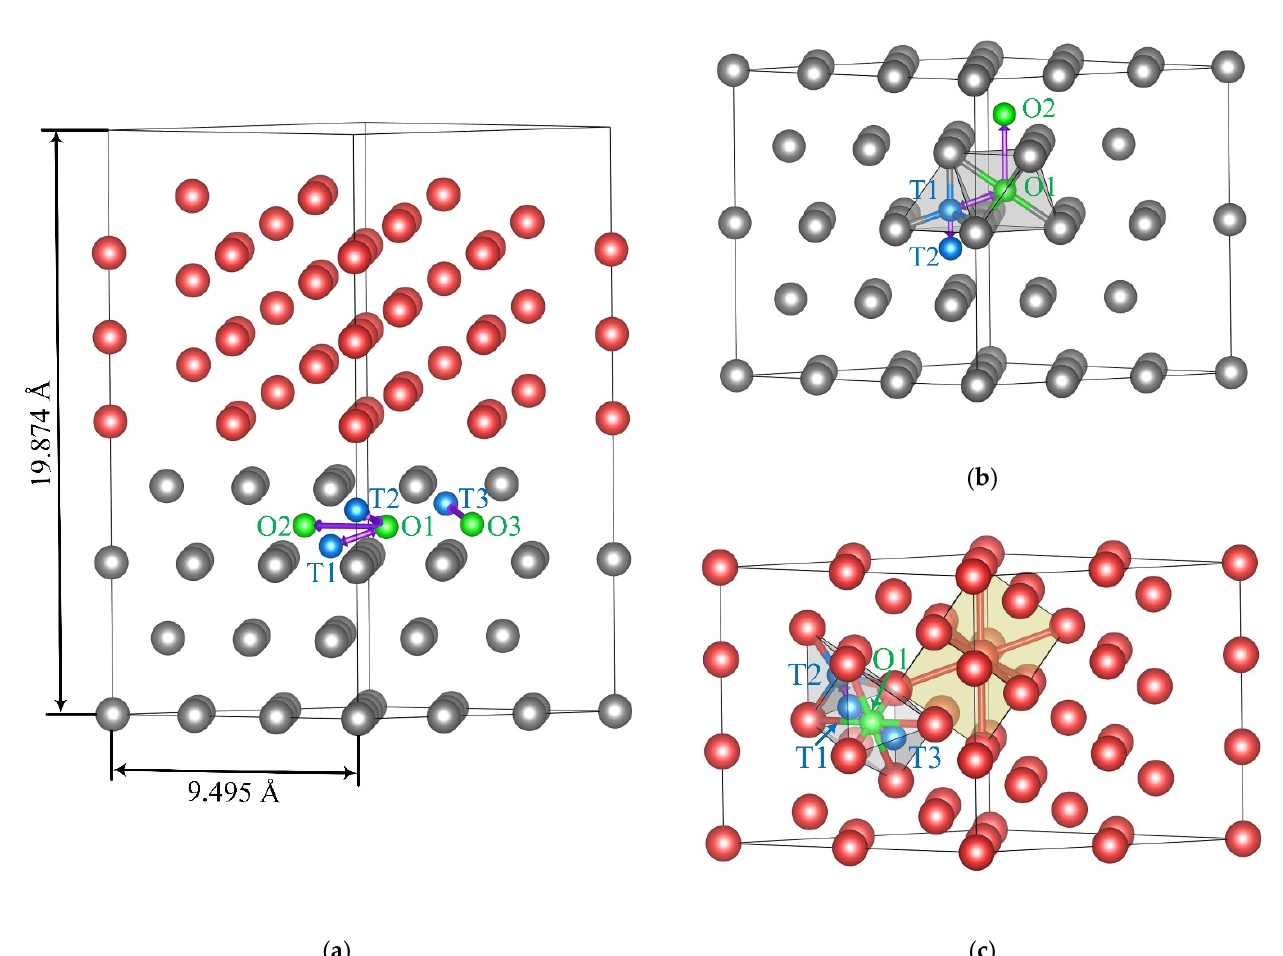
Figure 1. The supercell of ( a ) Zr 36 Nb 36 multilayer structures, ( b ) α -zirconium, and ( c ) niobium. Zirconium atoms are gray, niobium atoms are red, octahedral sites are green, and tetrahedral sites are blue. The directions of hydrogen diffusion jumps are indicated by violet arrows.